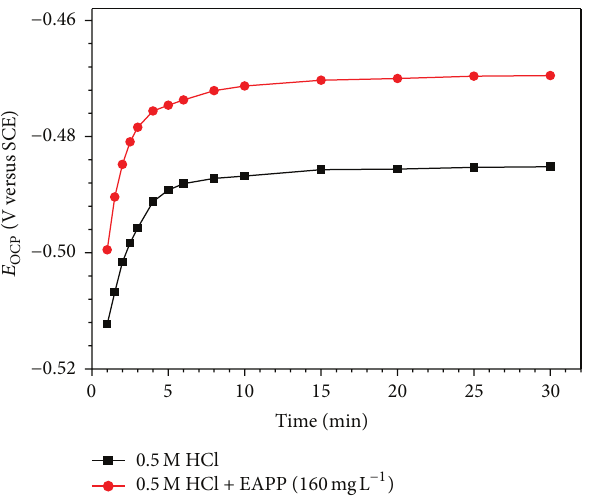
Figure 2: Open circuit potential-time curves for carbon steel in 0.5 M HCl in the absence and presence of 160mg L −1 EAPP at 300 K.